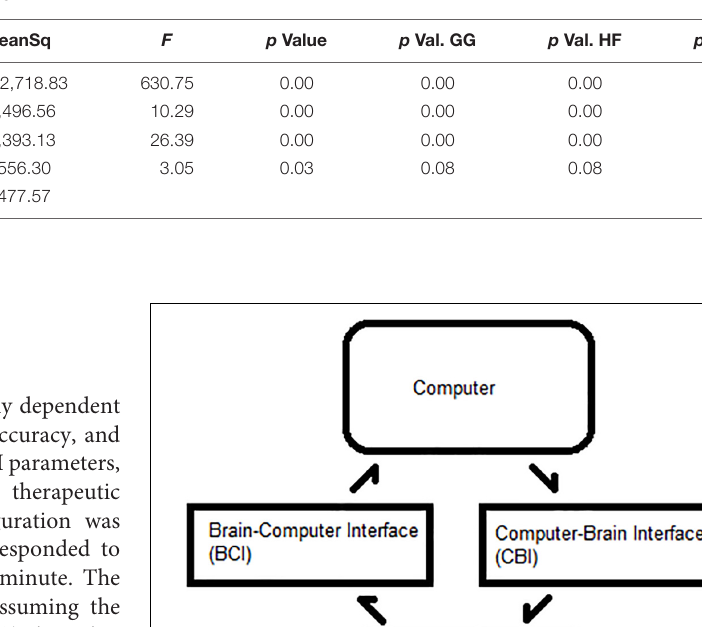
When the failure rate was increased to 50%, the